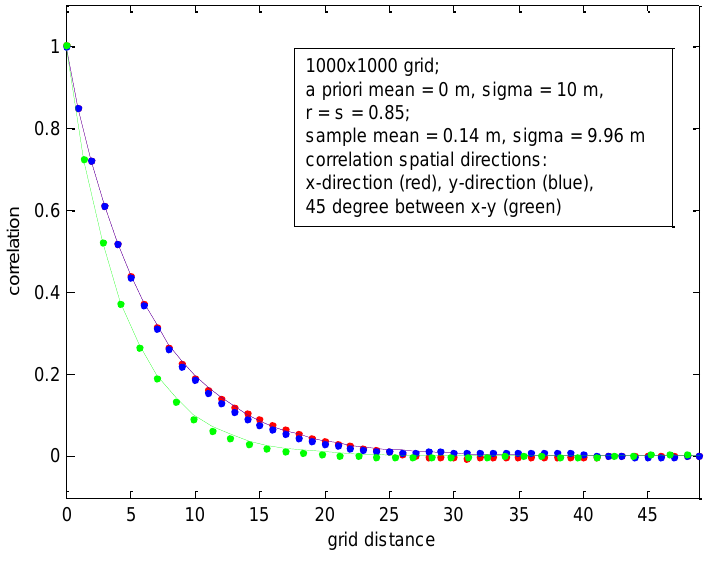
Figure 10. Semivariograms corresponding to 200 × 200 grid with the same a priori correlations for the x and y directions, evaluated across the y-direction for five different